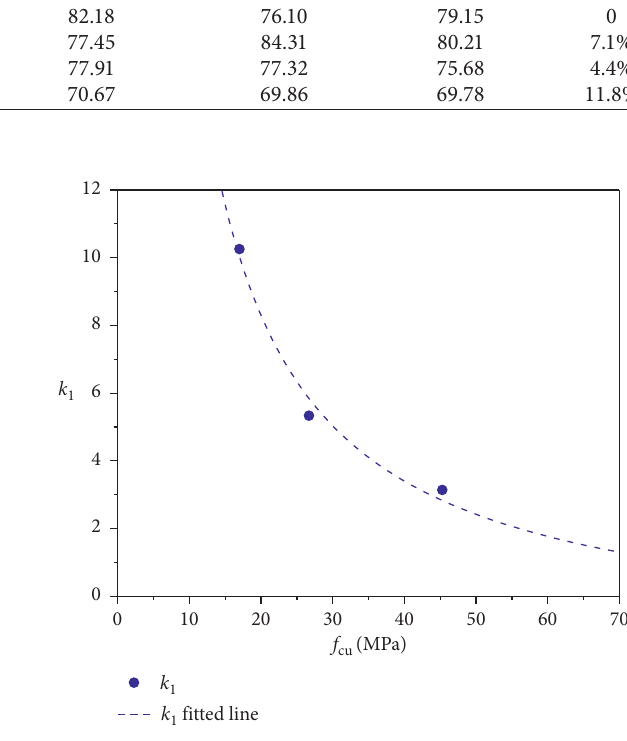
Figure 4: Influence of strength grade of concrete on the parameter k